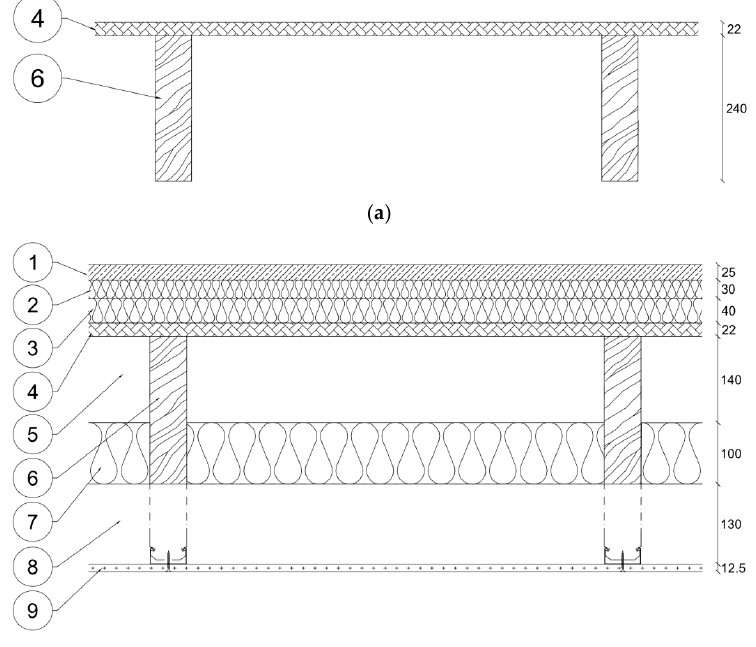
Figure 2. Cross-section of a beam and block floor (1 – concrete, 2 – hollow blocks, 3 –